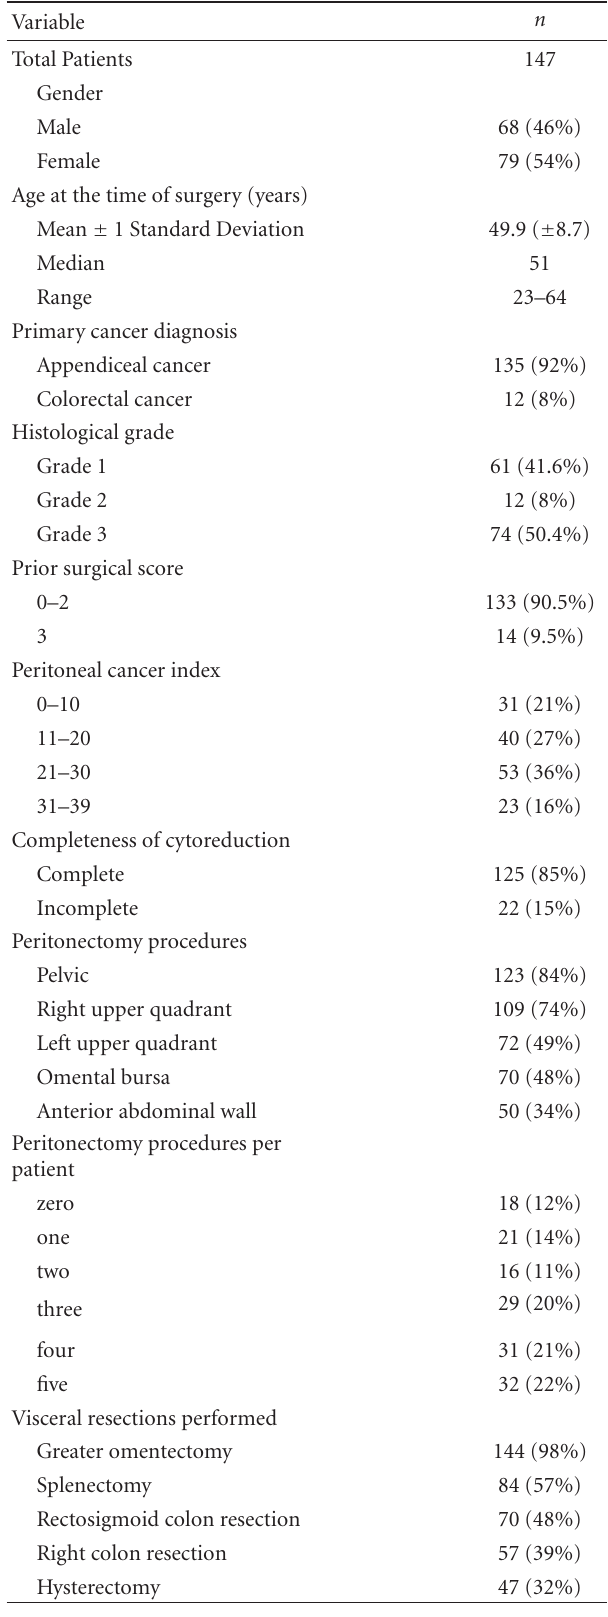
Table 1: Patients characteristics, quantitative prognosis indicators, peritonectomies, visceral resections, and intraoperative